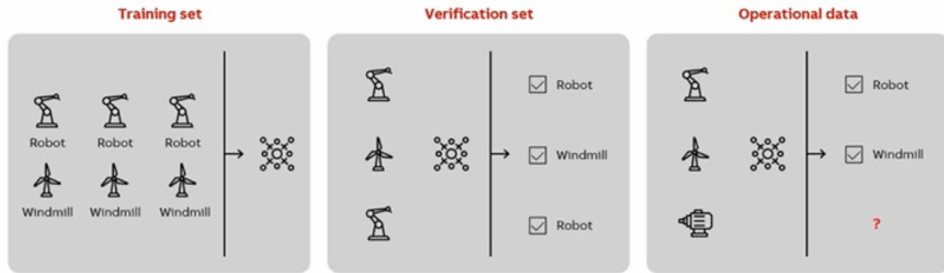
Figure 8. Concept of AI training from rich